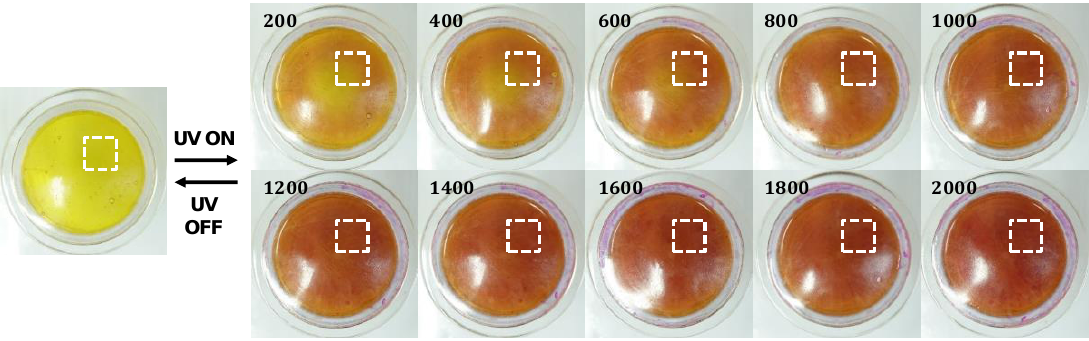
Figure 6. Colorimetric responses of PR fluids at different UV light intensities (unit: mW/𝑐𝑚 2 ) at ambient temperature.